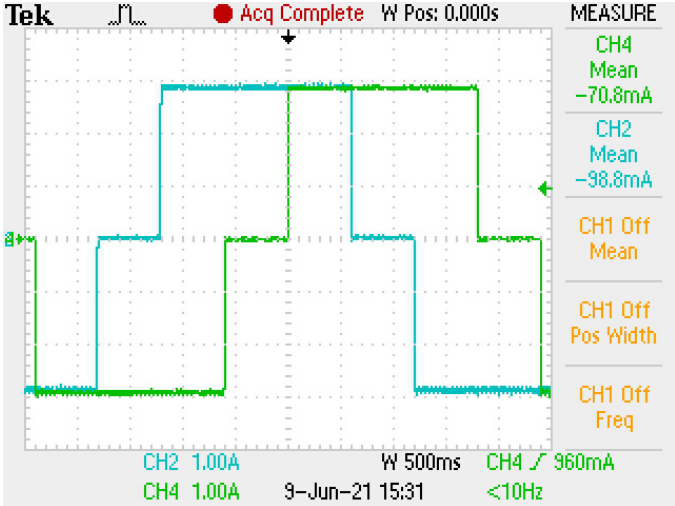
Figure 13. A–B coil currents in the half-step control scheme.